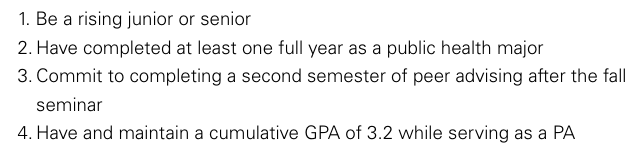
Table 1 | Eligibility for peer advising